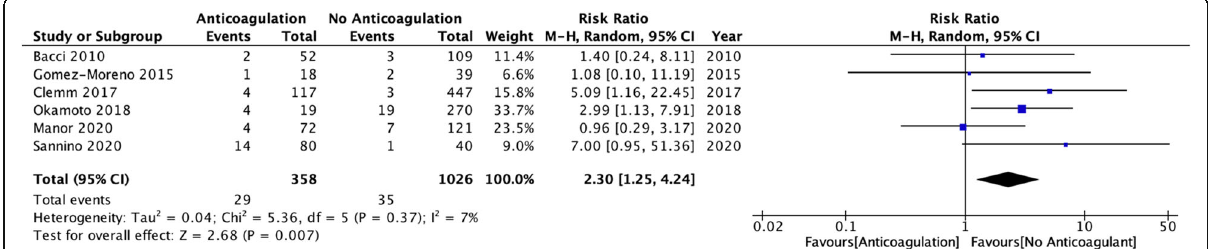
Fig. 2 Forest plot comparing continuation of anticoagulation therapy peri-operatively with controls of no anticoagulation. Mean relative risk and pooled relative risk is represented by the blue squares and black diamond